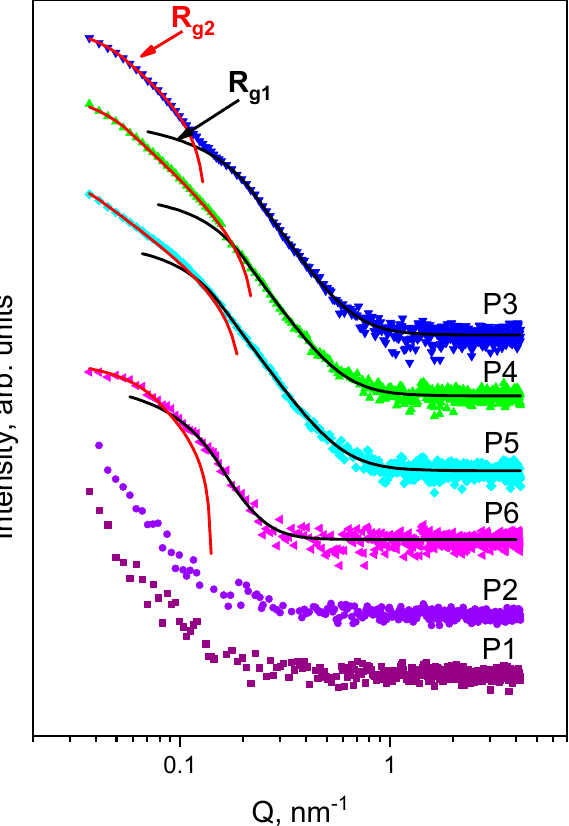
Figure 4. SAXS curves for Samples P1–P6 in excess PBS medium: P1—Lip (purple), P2—Lip–CTS (violet), P3—Ag/AgClNPs (blue), P4—Ag/AgClNPs–CTS (green), P5—Ag/AgClNPs–Lip (cyan) and P6—Ag/AgClNPs–Lip–CTS (magenta). Symbols are experimental data, and lines are fits by the generalized Guinier–Porod model (Equation (1) in the Supplementary Materials). For better visualization, the curves are spaced with a coefficient of 10 relative to each other in the intensity scale from the bottom to the top. Table 3. Structural parameters derived from the analysis of SAXS data and the calculated diameter (D SAXS = 2(5/3) 1/2 R g ) of the Ag and Ag/AgCl nanoparticles for silver-based samples (P3–P6). Silver-Based Samples’